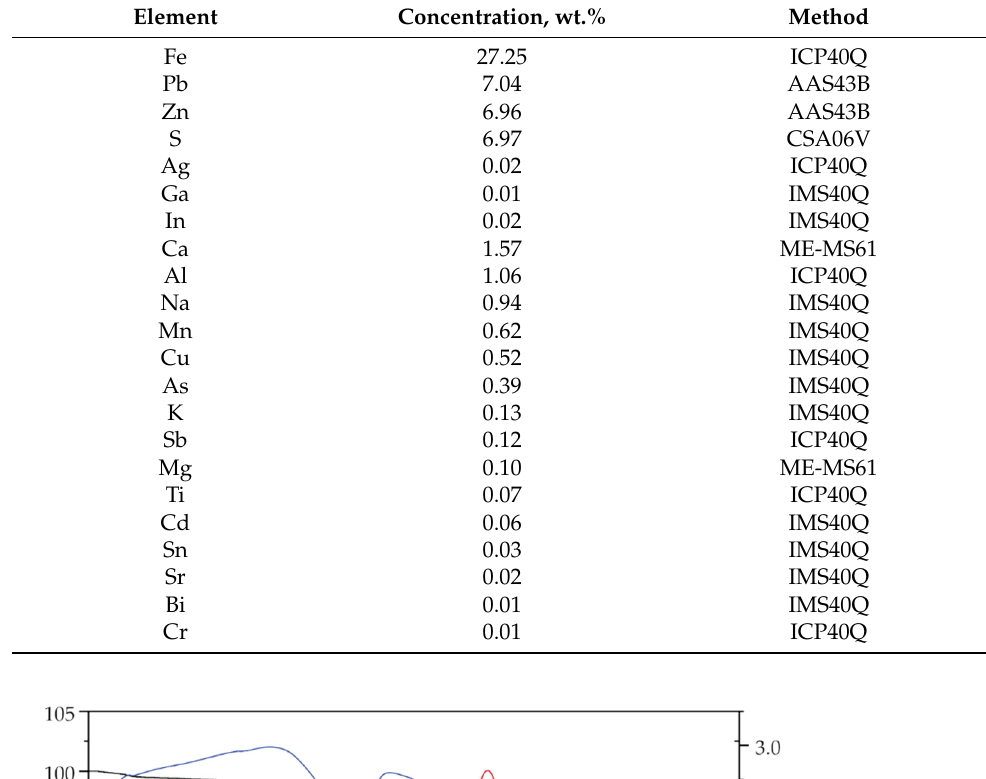
Table 2. Elemental analysis of jarosite-PbAg sludge. Element